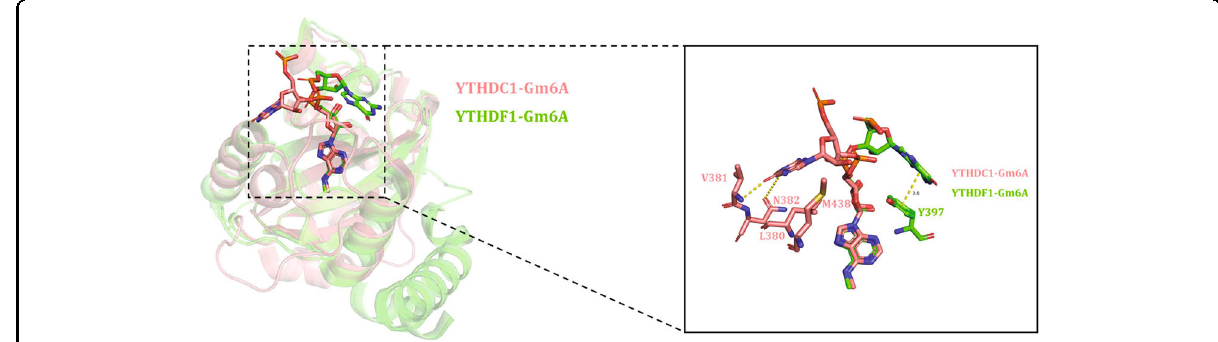
Fig. 4 Structural comparison of YTHDC1 and YTHDF1 reveals the structural basis for the discriminative recognition of the nucleotide preceding the m6A mark by YTHDC1. The YTHDC1-G(m6A) and YTHDF1-G(m6A) complexes are shown in the model as pink and green sticks, and the difference interactions between YTHDC1 and YTHDF1 with the G-1 nucleotide are highlighted with yellow dashed lines.